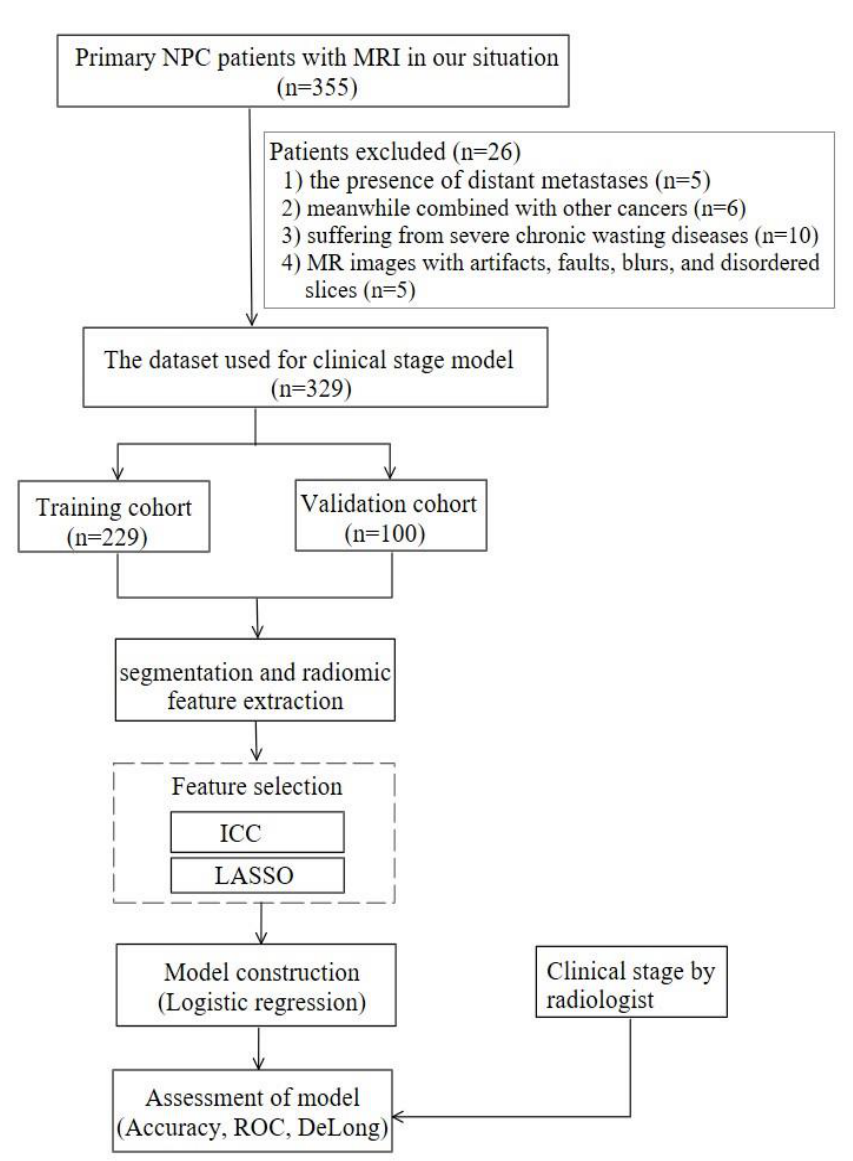
Figure 1. Flow chart of this